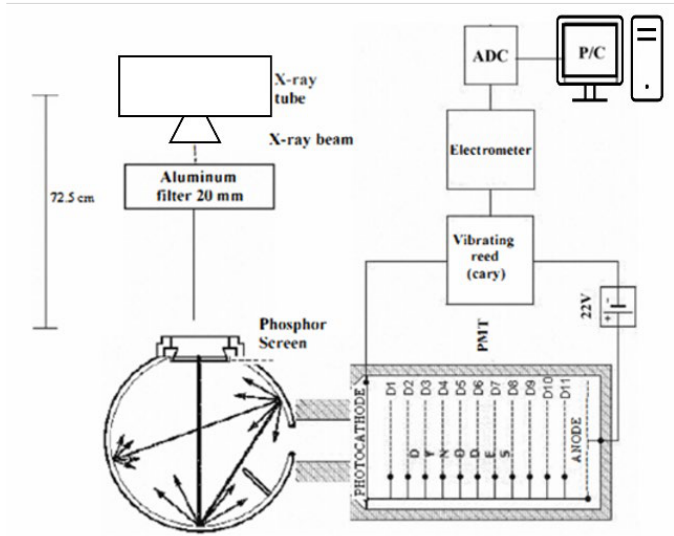
Figure 2. Experimental setup for the measurement of the emitted light energy flux comprising the integrating sphere, the PMT, and the vibrating reed electrometer.